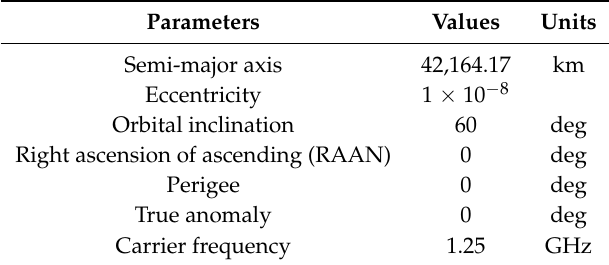
Table 3. Systematic parameters of GEO SAR